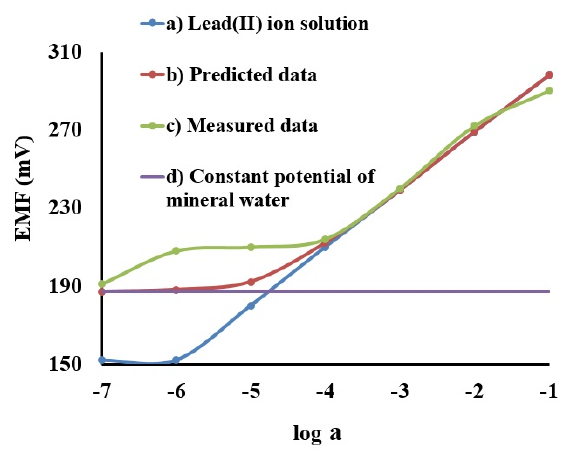
Figure 6. Application of the electrode membrane containing o-NPOE plasticizer and two equivalents of lipophilic ion-exchanger, under competitive conditions.